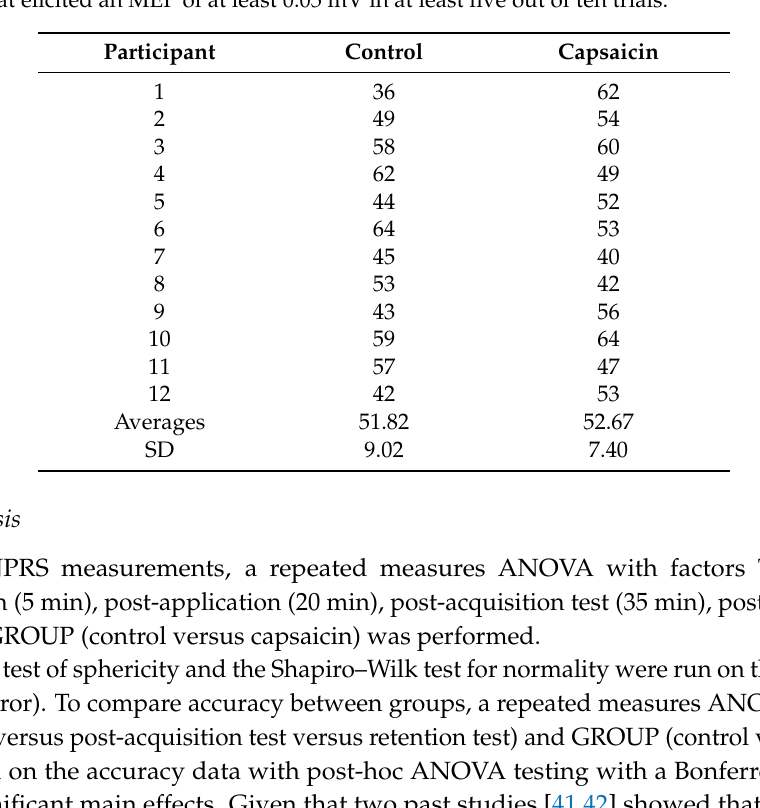
Table 1. Resting motor threshold (rMT) values that were determined by finding the lowest